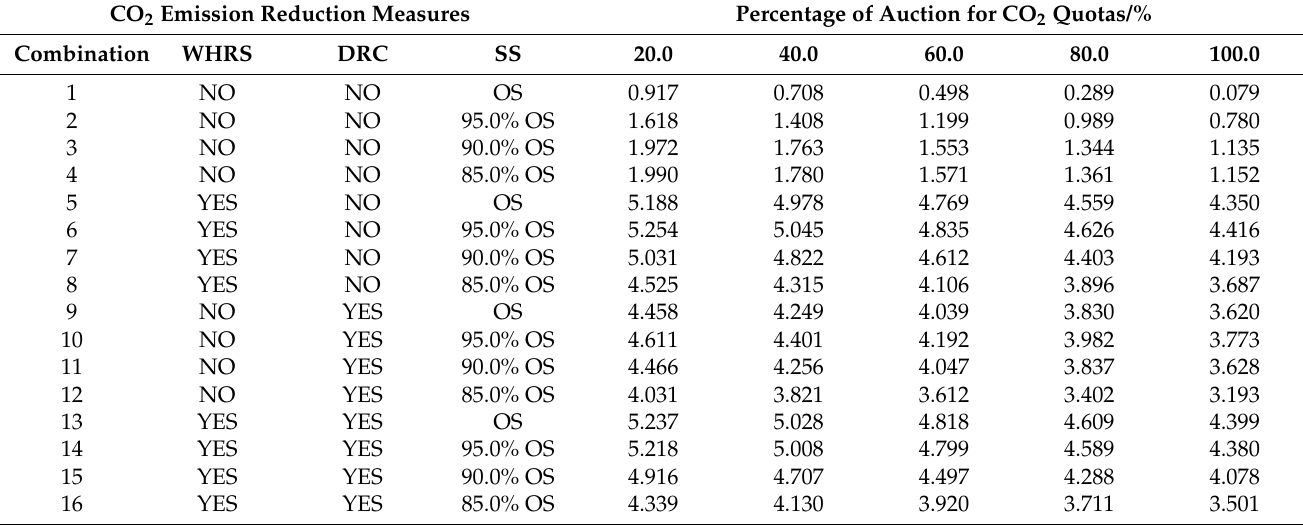
Table 7. Annual income of the container ship with different combinations of CO 2 emission reduction measures in